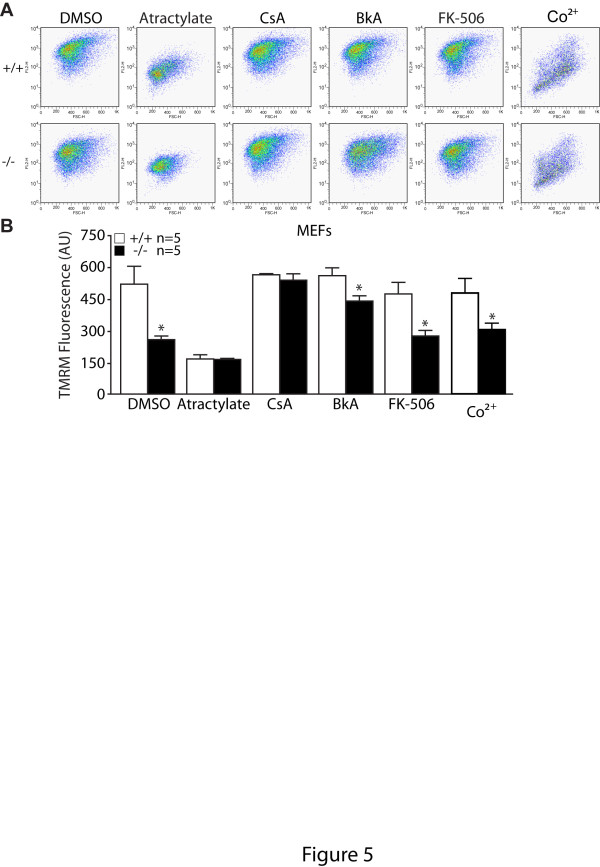
Blockade of mPTP opening attenuates the defect in mitochondrial transmembrane potential inPINK1−/− MEFs. A. Representative flow cytometry dot plots showing TMRM fluorescence in PINK1−/− and +/+ cells incubated with TMRM (50 nM) and atractylate (20 μM), CsA (1 μM), BkA (10 μM), FK-506 (5 μM) or Co2+ (1 mM). B. The bar graph shows mitochondrial membrane potential measured by TMRM fluorescence after FACS analysis following various treatment, atractylate (20 μM), CsA (1 μM), BkA (10 μM), FK-506 (5 μM) or Co2+ (1 mM). The number shown in the panel indicates the number of independent experiments performed. All data are expressed as mean ± SEM. * p < 0.05.